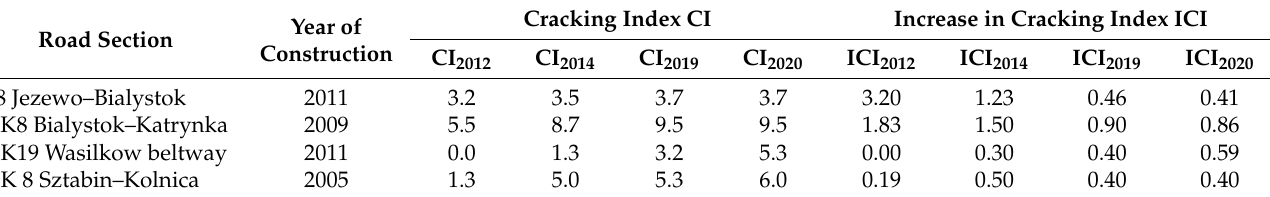
Table 2. Results of the field investigations of trial